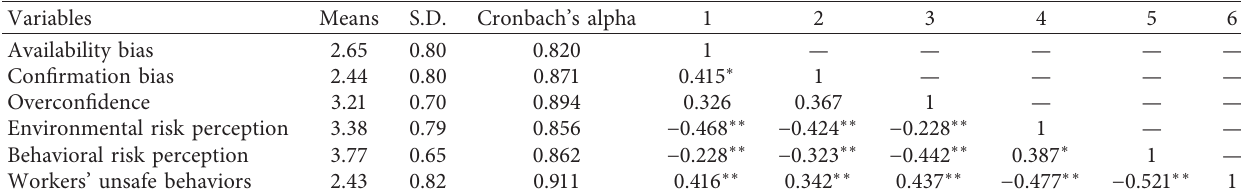
Table 4: Means, SD, reliability, and intercorrelations of all the